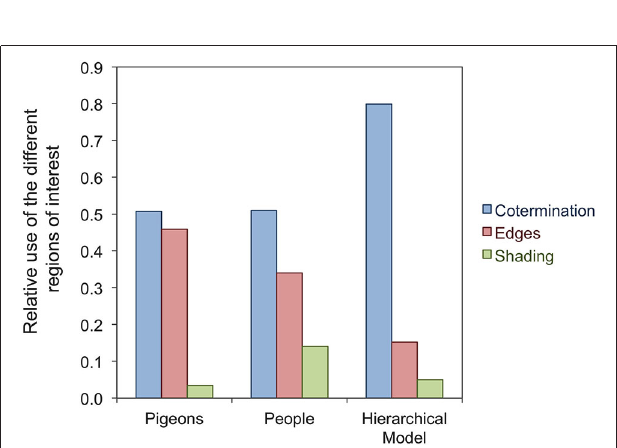
FIGURE 9 | Relative use of different regions of interest during geon recognition by pigeons, people, and a hierarchical model of object recognition